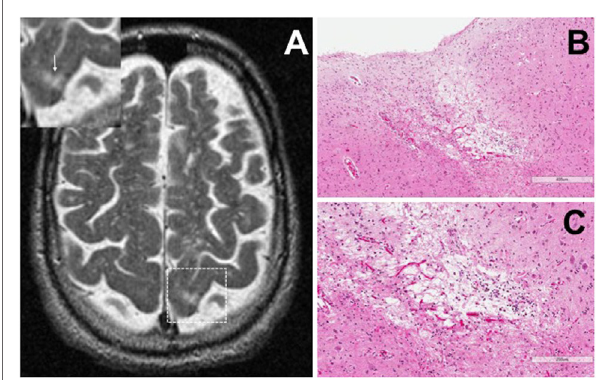
FigUre 1 | Representative axial T2-weighted magnetic resonance imaging (MRI) image from one case included in the study. The MRI image demonstrates partial CSF-signal intensity of a cortical microinfarct in the left occipital cortex (arrow in the inset) (a) . Hematoxylin and eosin-stained sections taken from the left occipital cortex show the classic features of a cortical microinfarct marked by a small localized necrotic core immediately adjacent to the cortical surface [ (b,c) ; × 10 and × 20 magnification,